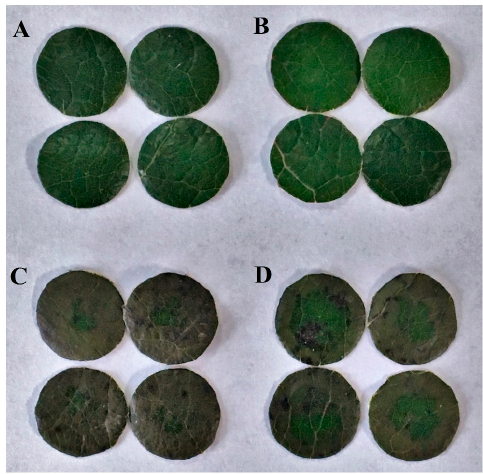
Figure 1. Effect of exogenous melatonin (MT) on phenotypes of poplar leaf discs exposed to methyl viologen (MV) for 24 h. ( A ) Control; ( B ) Control + MT; ( C ) MV; ( D ) MV + MT. Poplar leaf discs were pretreated with 150 μ M melatonin in the dark for 12 h, and then, leaf discs were exposed to 50 μ M methyl viologen in the light for 24 h.